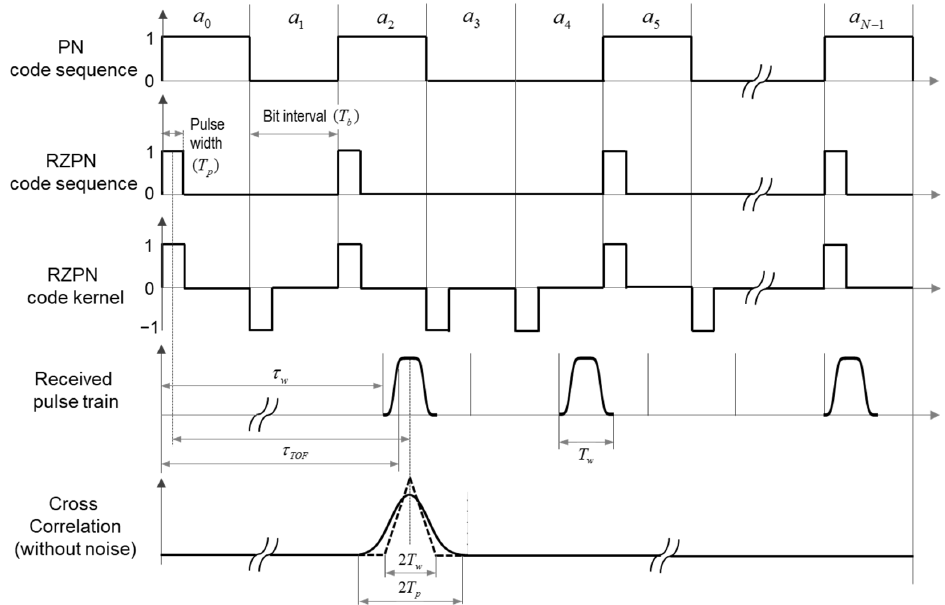
Figure 2. Illustration of RZPN laser altimeter principle. τ TOF representing the mean TOF to the target surface indicates the time difference between the centers of the transmitted rectangular pulse and corresponding received pulse. τ w is the shortest TOF for the first transmitted pulse corresponding to m = 0 in the FMGB model, and T w is the time difference between the shortest TOF for the first transmitted pulse and the longest TOF for the last transmitted pulse corresponding to m = M . For the cross-correlation in absence of noise, the solid line means the cross-correlation of broadened pulse trains, whereas the dotted line with a triangle shape corresponds to the case in which the received pulse is not broadened.